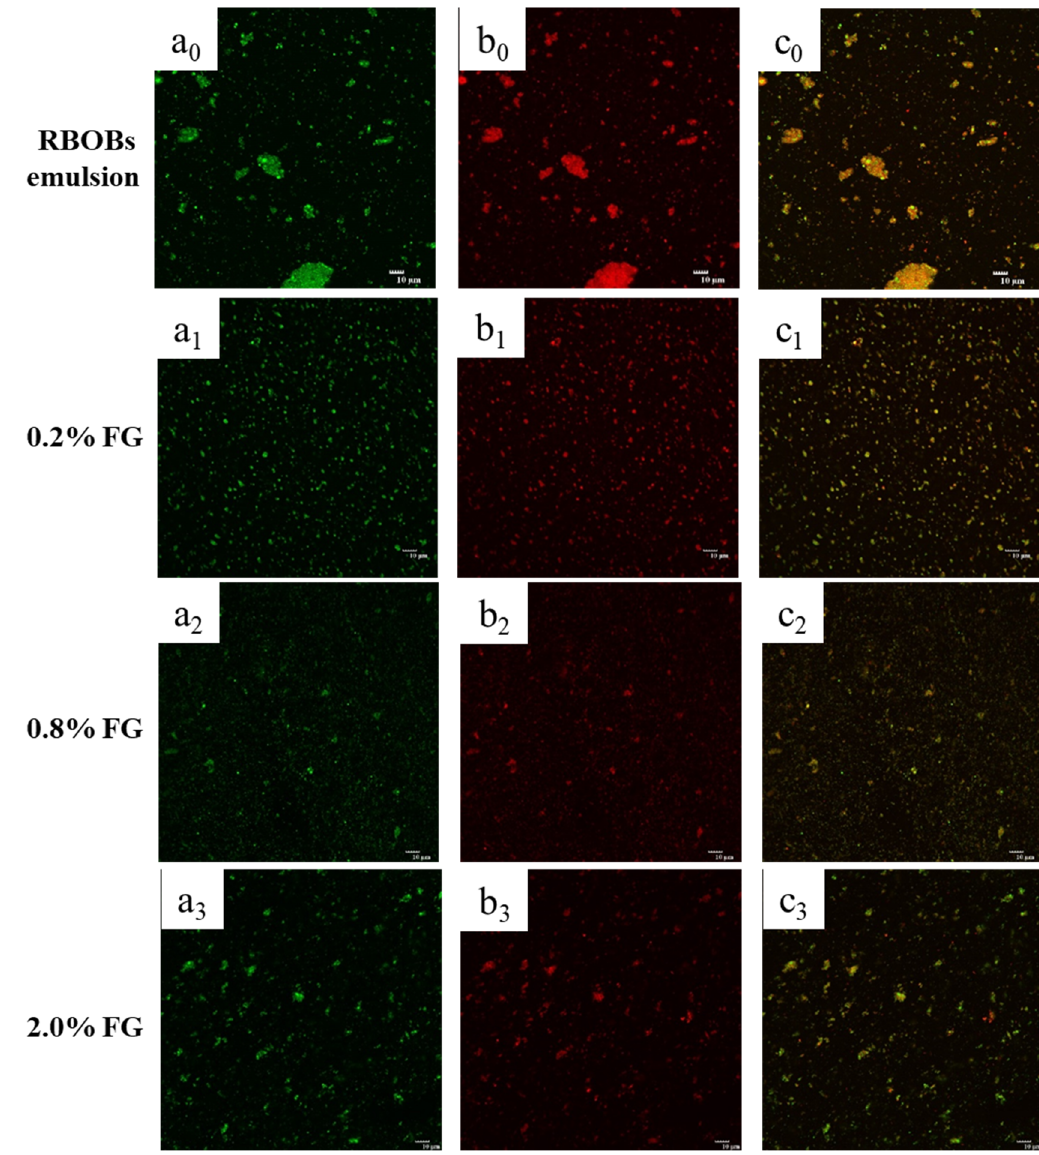
Figure 4. CLSM of RBOB emulsion and RBOB-FG emulsion-filled gel with varying FG concentrations: ( a 0 – a 3 ) are oils (stained green); ( b 0 – b 3 ) are proteins (stained red); and ( c 0 – c 3 ) are oils and proteins.